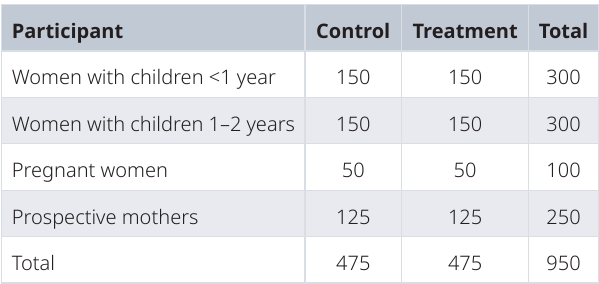
Table 2. Breakdown of quantitative data collection by treatment and control